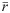
Linear dynamical transfer properties of multicompartmental model neurons. We studied the dynamics of AP initiation in neuronal models, by estimating the temporal modulation of the instantaneous firing probability, in response to the somatic injection of a noisy current (B, green trace). The offset of this current (A-B, dashed grey trace) was weakly modulated over time at a harmonic frequency f. With Circular Statistics methods, we referred the time of each AP to the corresponding phase of the input oscillation. Then we regarded in the complex plane each AP as a vector with unitary length (C, filled colored markers) (C). We finally estimated the magnitude and phase of the vector sum r¯ (C), averaging together tens of thousands of APs and thus resulting in a vector with length lower than 1. We systematically explored magnitude and phase for a broad range of values of f (i.e. 10–1000 cycle/s). As the soma-AIS distance increased, the somatic AP waveform varied and became steeper (D).